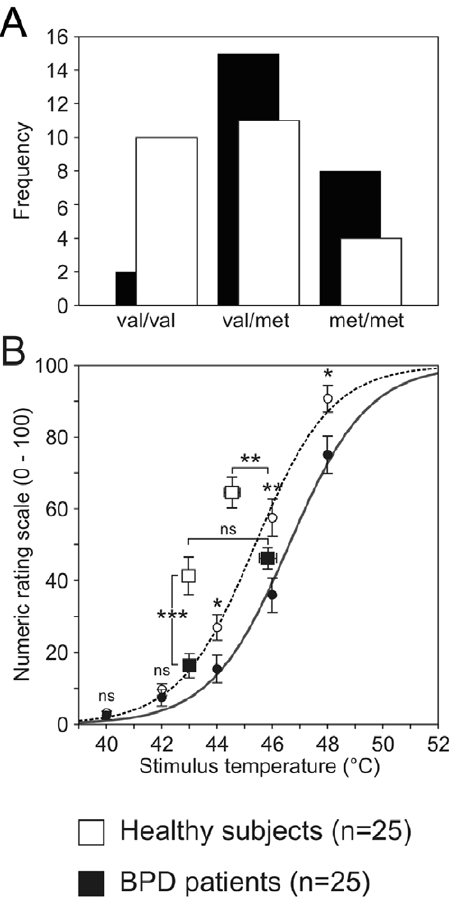
Figure 1. Patients suffering from BPD are less heat pain sensitive independent of the val158met polymorphism. (A) Genotype distribution of the val158met polymorphism in healthy controls (open) and BPD patients (filled bars) do not differ. (B) Heat pain perception was markedly reduced in BPD. Dose-response function in the pretest session (circles) and stimulus temperatures applied during fMRI (squares) did significantly differ between controls and BPD (ns p . 0.4; * p , 0.05; ** p , 0.01; *** p , 0.001, students t-test).